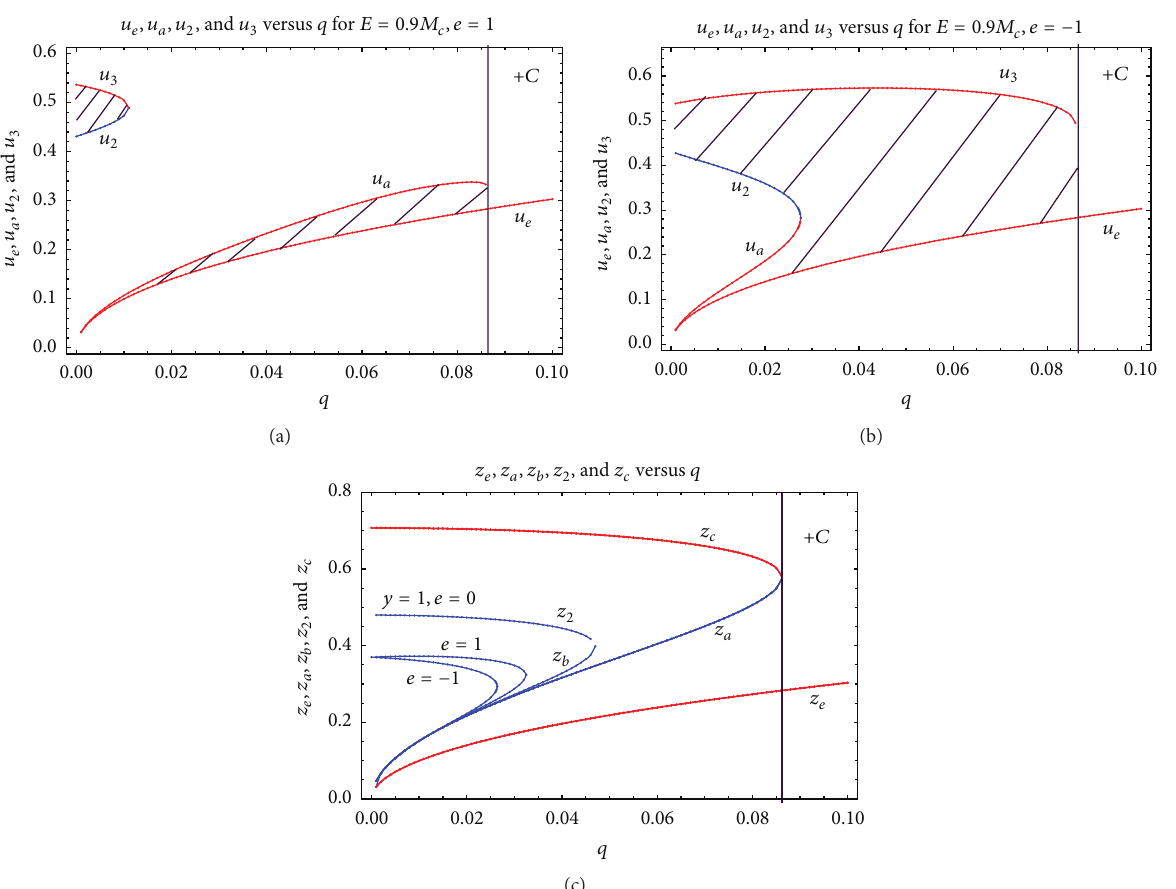
𝑒 = 0,±1 are presented. For all plots with charge 𝑒 ̸= 0 , we set 𝑔